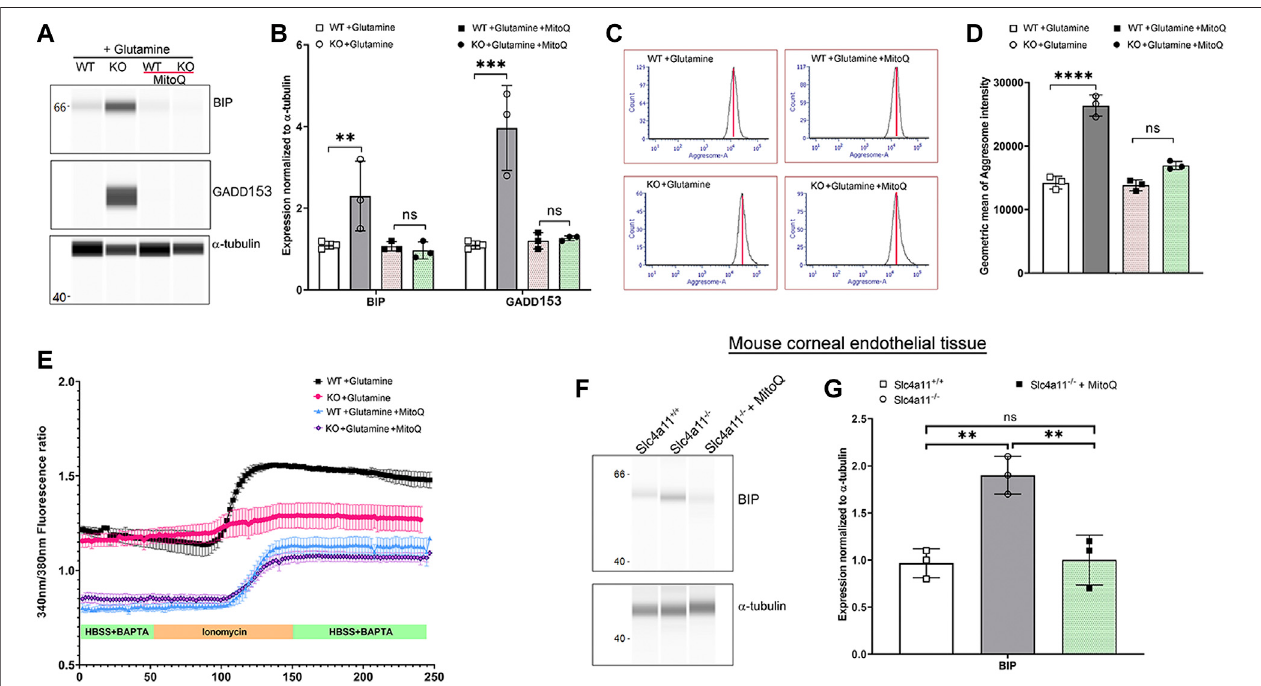
FIGURE6| QuenchingMitoROSreversesERstressin Slc4a11 KO. (A) WesimmunoassayforBIPandGADD153of Slc4a11 WTandKOMCECtreatedwith2 μ M MitoQ. (B) Quanti fi cation of Wes immunoassay. N = 3. ** p < 0.01, *** p < 0.001. Student ’ s t-test. (C) Flow cytometry analysis of WT and KO MCEC treated with 2 μ M MitoQ to determine the presence of aggresomes. (D) Quanti fi cation of the geometric mean of aggresome intensity. N = 3. p < 0.0001. Student ’ s t-test. (E) Slc4a11 WT and KO MCEC were cultured in media with glutamine ± 2 μ M MitoQ. The cells were loaded with Fura-2 and perfused with Hanks Buffer with BAPTA to establish a baseline(0 – 50 s), followedbyperfusion withionomycinfor100 s. (F) WesimmunoassayforBIPin Slc4a11 WTand KOcornealendothelialtissueofanimalstreatedwith or without MitoQ. (G) Quanti fi cation of Wes immunoassay. N = 3. ** p < 0.01, ns-not signi fi cant.